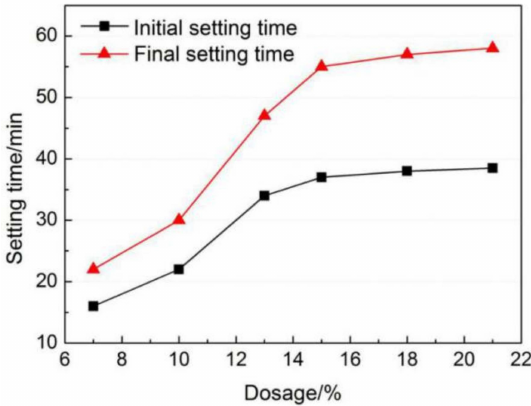
Figure 4. E ff ects of gypsum dosage on setting time of AMCSA.